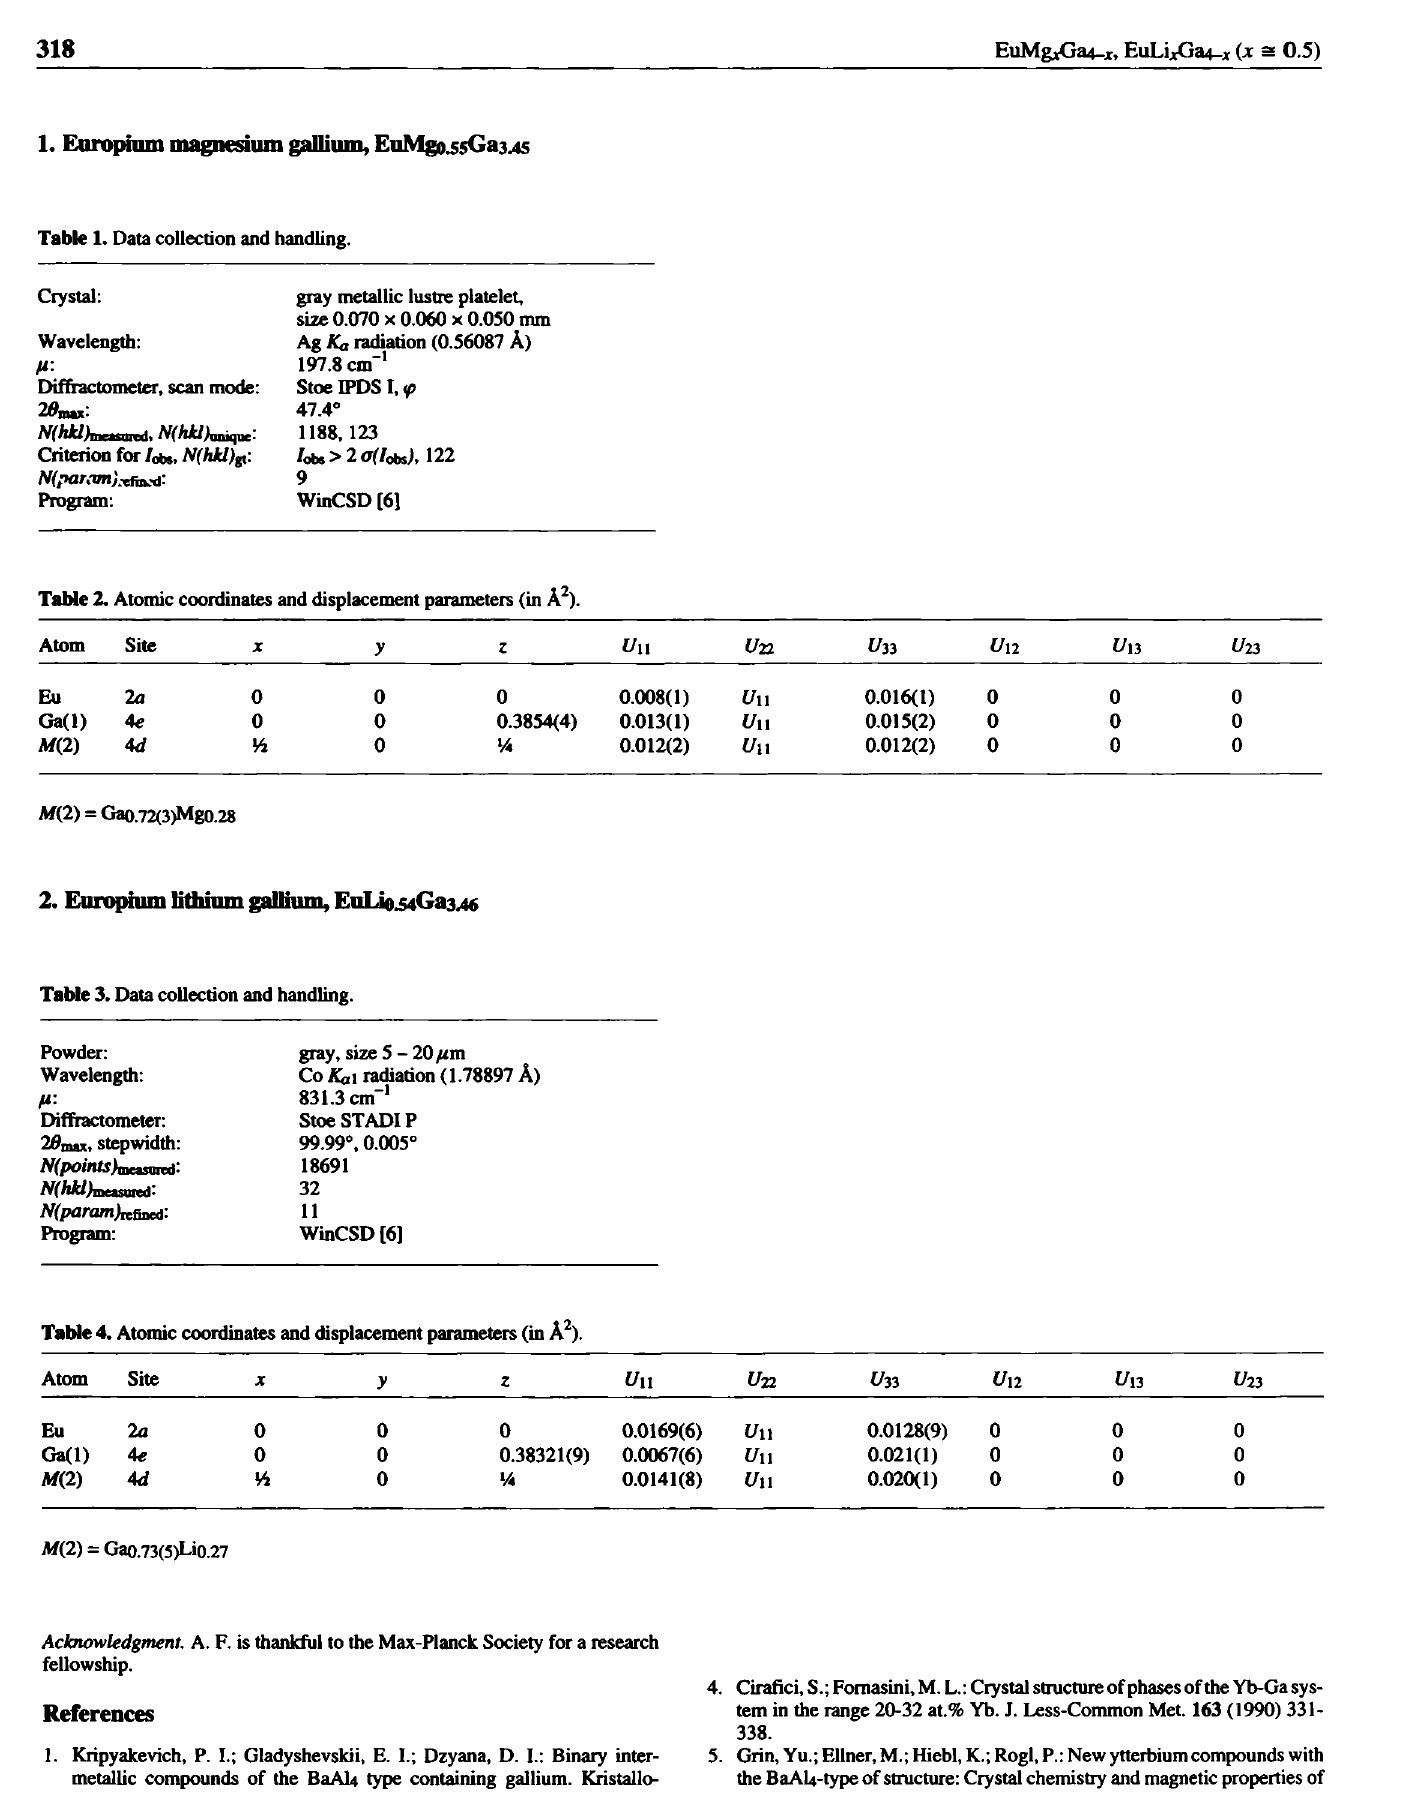
Table 4. Atomic coordinates and displacement parameters (in A 2